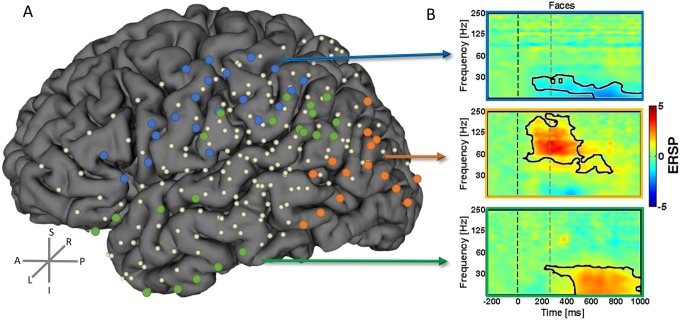
The topography of high frequency oscillations.We found distinct high frequency activity patterns during the ambiguous object recognition/perceptual decision task. The position of the electrodes per subject belonging to each of the clusters were marked as dots (in three distinct colors) in the coregistered brain. These patterns have distinct sources in the brain as represented by the correspondent dots. B) The example TF plots are a group average of all the represented electrodes of that cluster (N = 3 subjects for “blue” labels; N = 4 subjects for “orange” and “green” labels). Data (dB) are presented for the Mooney faces condition but these results could be generalized for the other conditions (see Figure A in S1 File). The black line segmented “blobs” in the plots depict the TF spectral–temporal patterns which are significant (blue z = -3.12, p<0.0017; orange, z = 3.11, p<0.0018; green, z = 3.09, p<0.0019). The dashed lines mark the start and end of stimulus.